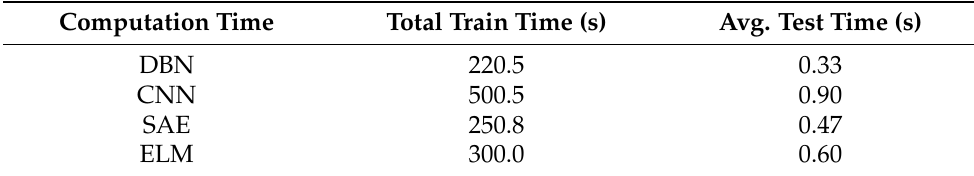
Table 6. Computation time for the analyzed classifiers. Total training time and average computation time for one test sample (HSI